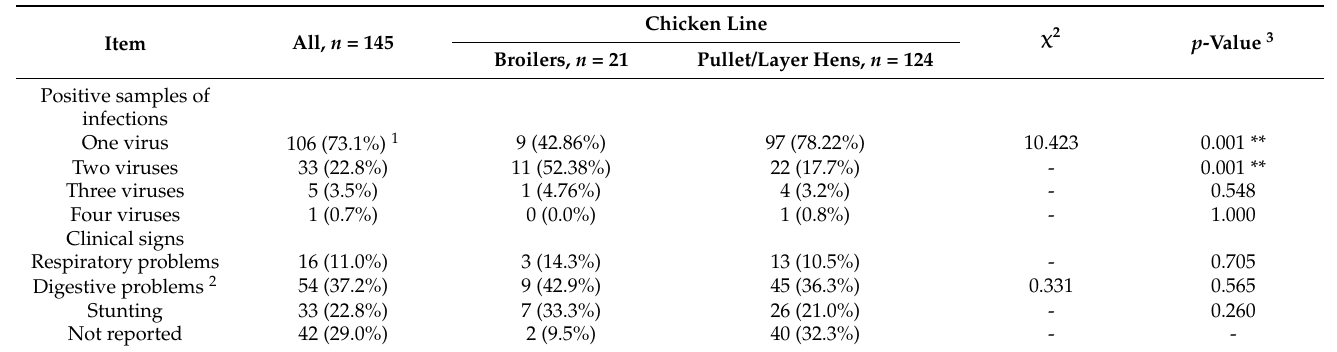
Table 8. Positive samples with single and multiple viral infections and clinical signs according to bird